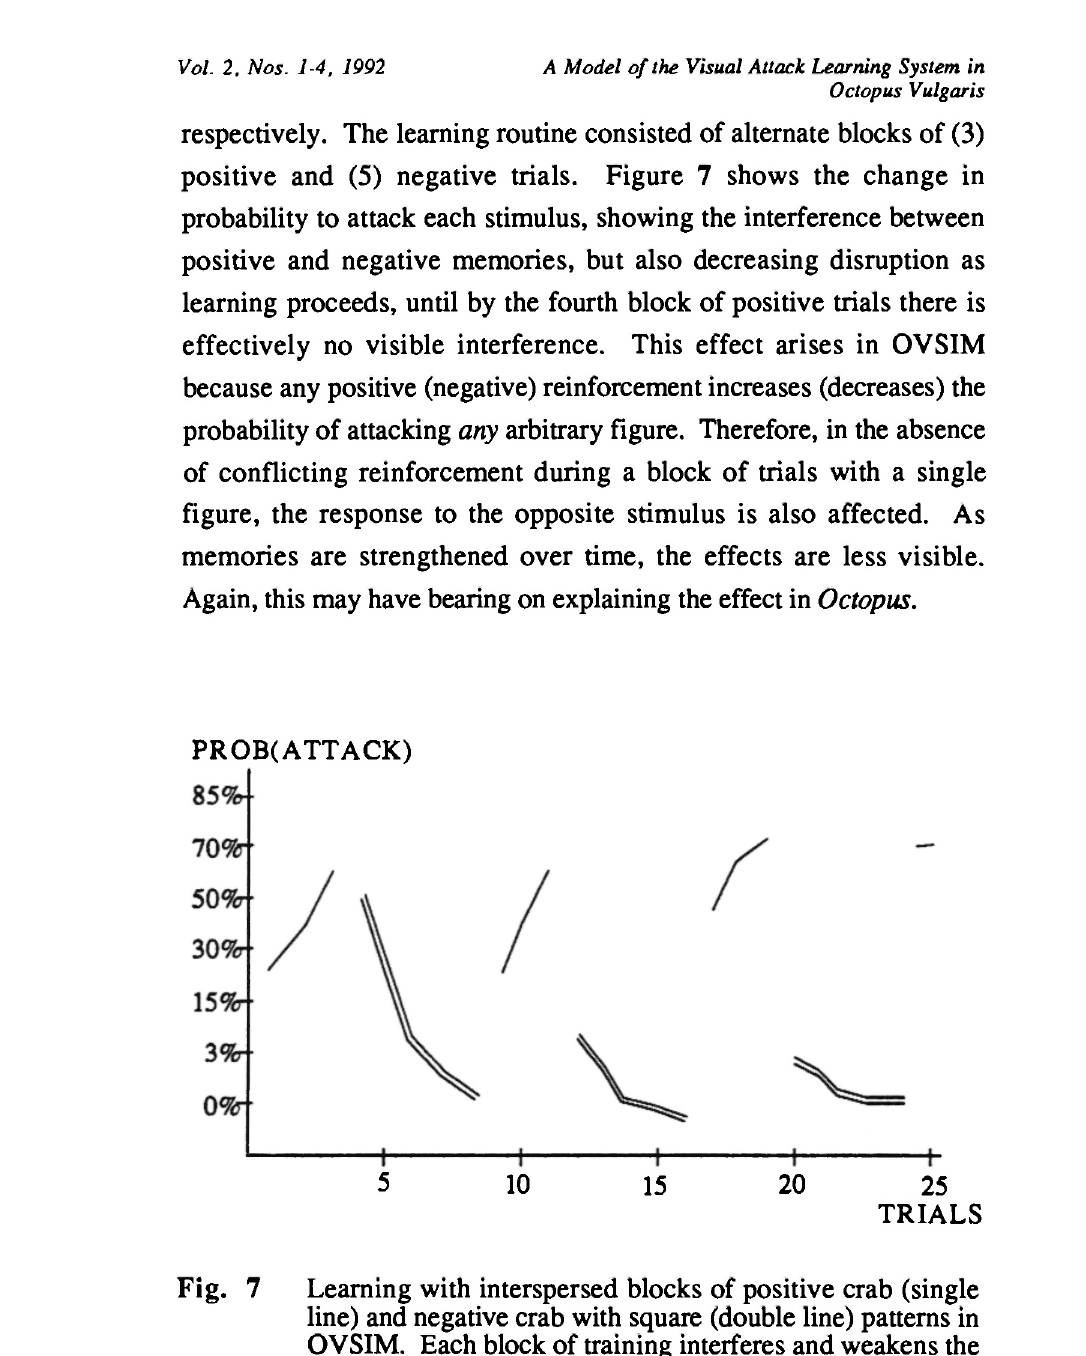
Fig. 7 Learning with interspersed blocks of positive crab (single line) and negative crab with square (double line) patterns in OVSIM. Each block of training interferes and weakens the opposite memory; but as learning proceeds, the interference is less. Data averaged from 10